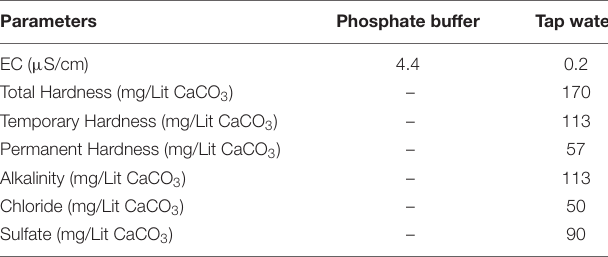
TABLE 1 | Analysis of various parameters of phosphate buffer and tap